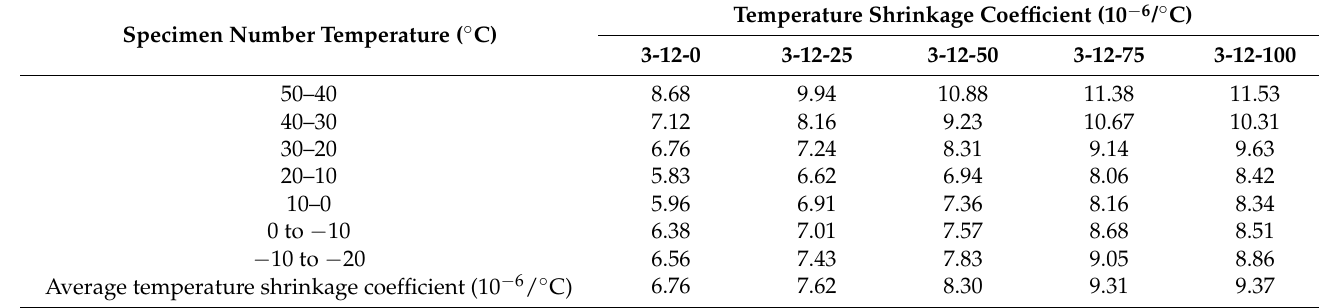
Table 5. Results of the temperature shrinkage test.